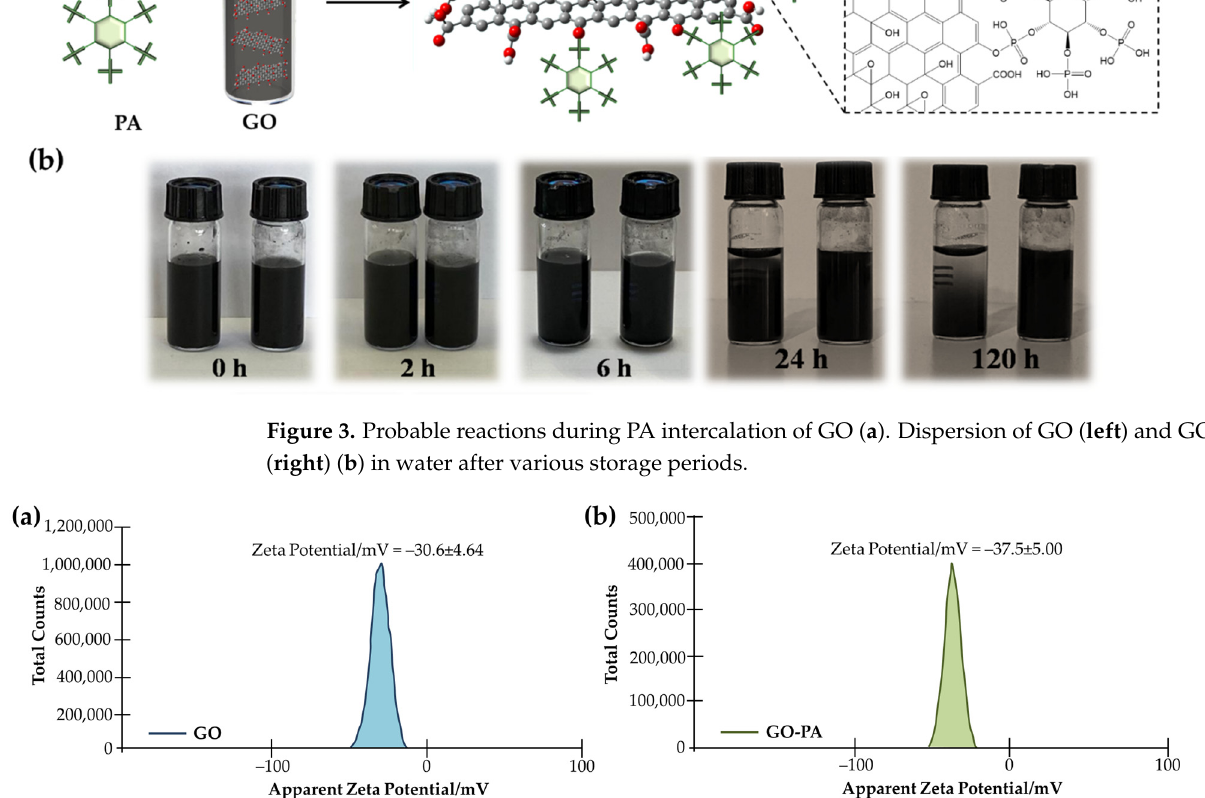
Figure 3. Probable reactions during PA intercalation of GO ( a ). Dispersion of GO ( left ) and GO-PA ( right ) ( b ) in water after various storage periods.